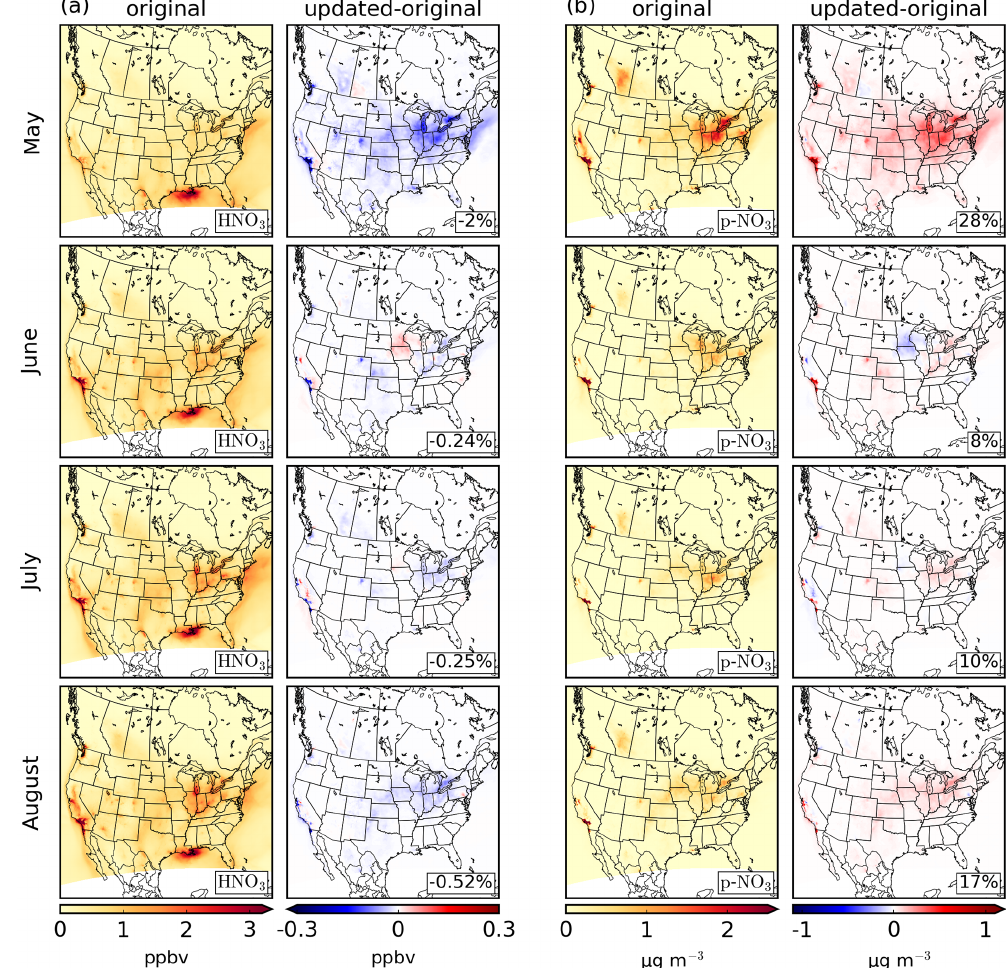
Figure 10. Same as Fig. 5, except for (a) HNO 3 and (b) p-NO 3 .